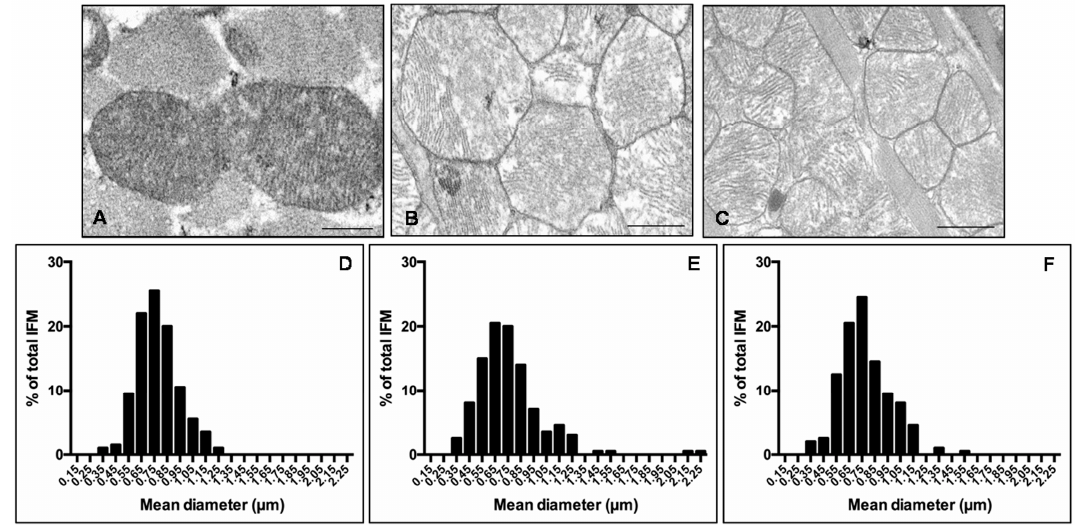
Figure 4. Inter-myofibrillar heart mitochondria features. Photomicrographs showing heart mitochondria of lean mice ( A ), ob / ob mice ( B ) and ob / ob mice treated with melatonin ( C ). Representative ultrastructural photomicrographs of IFM mitochondria closely packed inside myofibrils of sarcomeres. Scale Bar = 500 nm. The graphs summarize the IFM mitochondria diameter and distribution along size-classes of lean mice ( D ), ob / ob mice ( E ) and ob / ob mice treated with melatonin ( F ). Lean mice treated or not with melatonin displayed similar “normal” nuclear features of cardiomyocytes, so they are defined generically as “lean” mice.